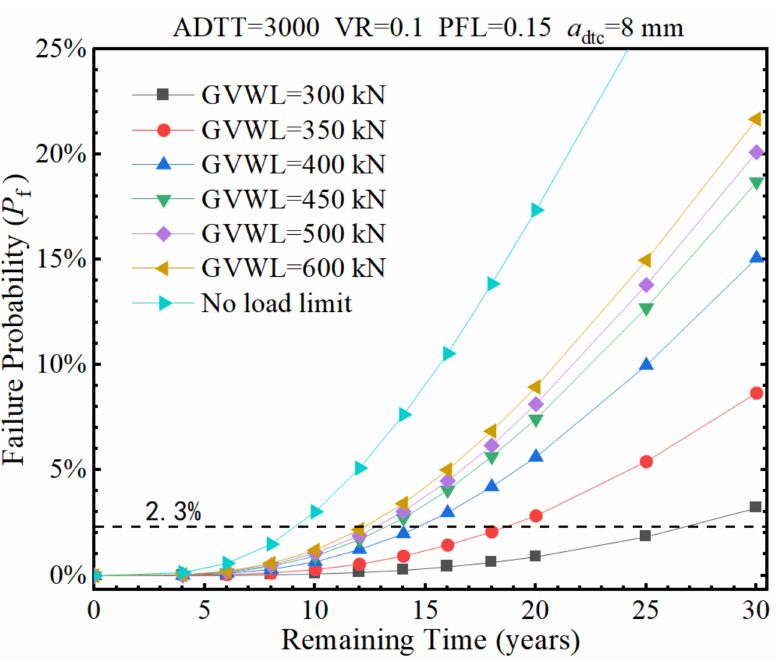
Figure 18. Failure probability of the fatigue detail under various GVWLs.